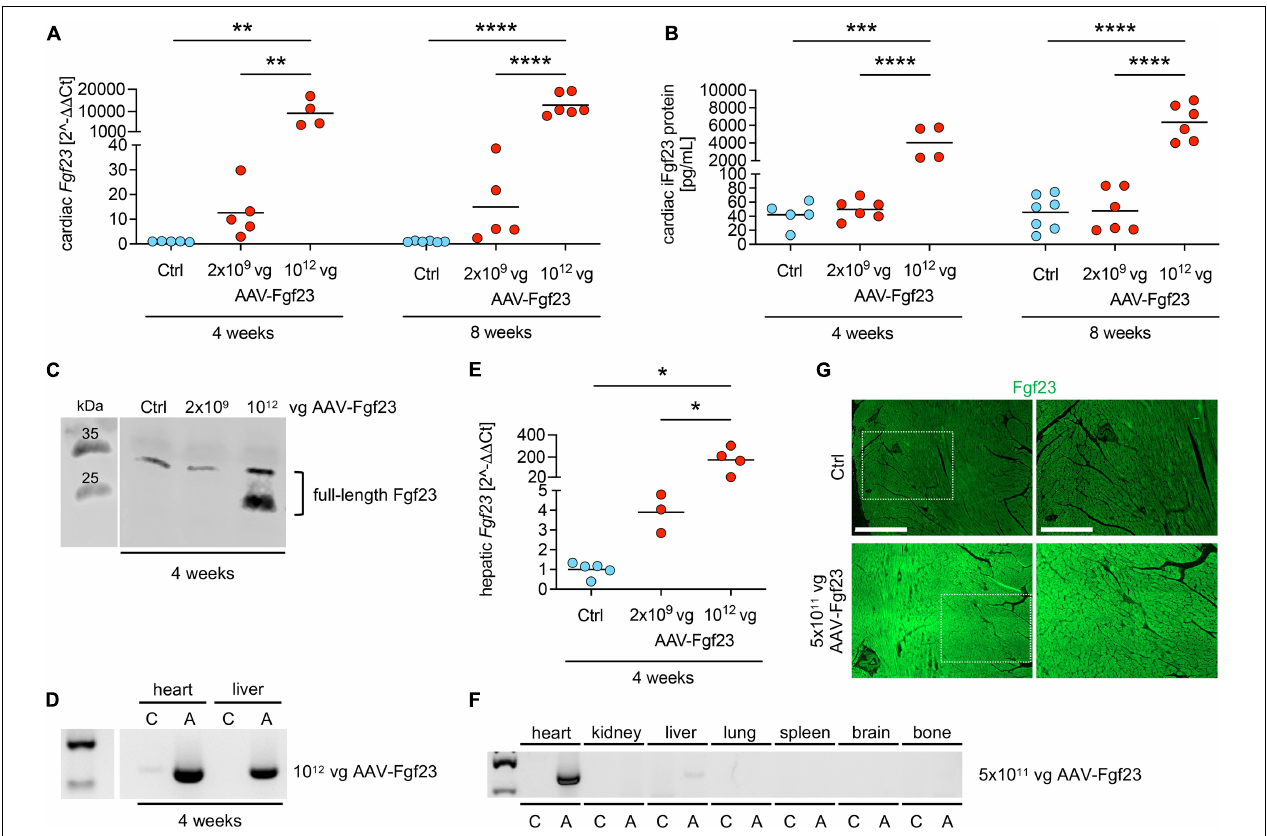
FIGURE 1 | Dose- and time-dependent evaluation of AAV-Fgf23. (A) Relative cardiac Fgf23 mRNA expression is dose-dependently increased in AAV-Fgf23 mice compared to Ctrl, irrespective of the duration of exposure. (B) ELISA-based quantification of cardiac Fgf23 protein in heart tissue lysates shows increased intact Fgf23 (iFgf23) protein only in AAV-Fgf23 mice administered with 10 12 vector genomic particles (vg) compared to Ctrl. (C) Representative immunoblotting of Fgf23 in cardiac tissue demonstrates increased iFgf23 protein in the 10 12 vg AAV-Fgf23 group after 4 weeks compared to Ctrl. (D) Semi-quantitative PCR targeting AAV vector shows excessive virus transduction after 4 weeks in the heart and the liver of 10 12 vg AAV-Fgf23 mice (A) compared to Ctrl (C). (E) Hepatic Fgf23 mRNA expression is significantly increased after 4 weeks in 10 12 vg AAV-Fgf23 mice compared to Ctrl. (F) By injecting 5 × 10 11 vg AAV-Fgf23, semi-quantitative PCR targeting AAV vector shows distinct virus transduction in the heart compared to Ctrl, whereas transduction in liver tissue was very low and absent in kidney, lung, spleen, brain, and bone tissue. (G) Immunofluorescent staining of cardiac mid-chamber sections demonstrates uniform Fgf23 (green) overexpression in almost all cardiac myocytes of the left ventricle in AAV-Fgf23 mice compared to Ctrl (original magnification × 20; scale bar, 500 and 250 µ m, respectively). Data are given as scatter dot plots with means; * p < 0.05, ** p < 0.01, *** p < 0.001, and **** p < 0.0001 analyzed using one-way ANOVA or Kruskal–Wallis test followed by Sidak’s or Dunn’s multiple comparisons post hoc tests, respectively, according to Shapiro–Wilk normality test; n = 3–7 mice per